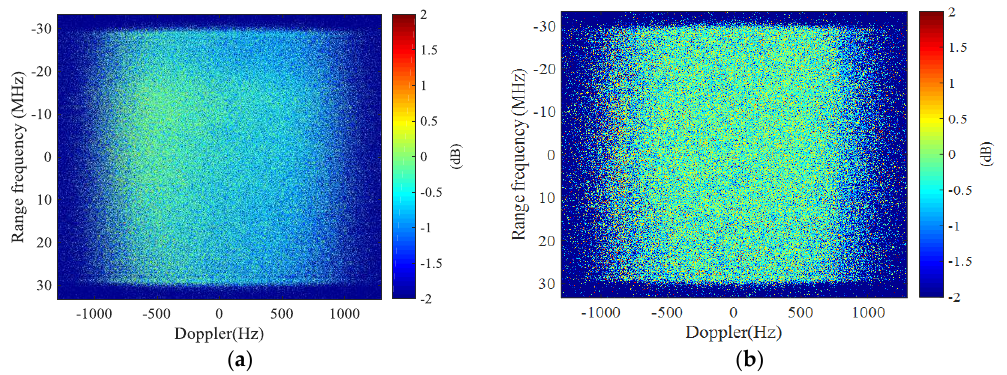
Figure 6. Amplitude imbalances in the 2-D spectral domain before and after imbalance correction (calibration bandwidths: 60 MHz in range and 1.58 kHz in Doppler): ( a ) before imbalance correction; and ( b ) after imbalance correction.